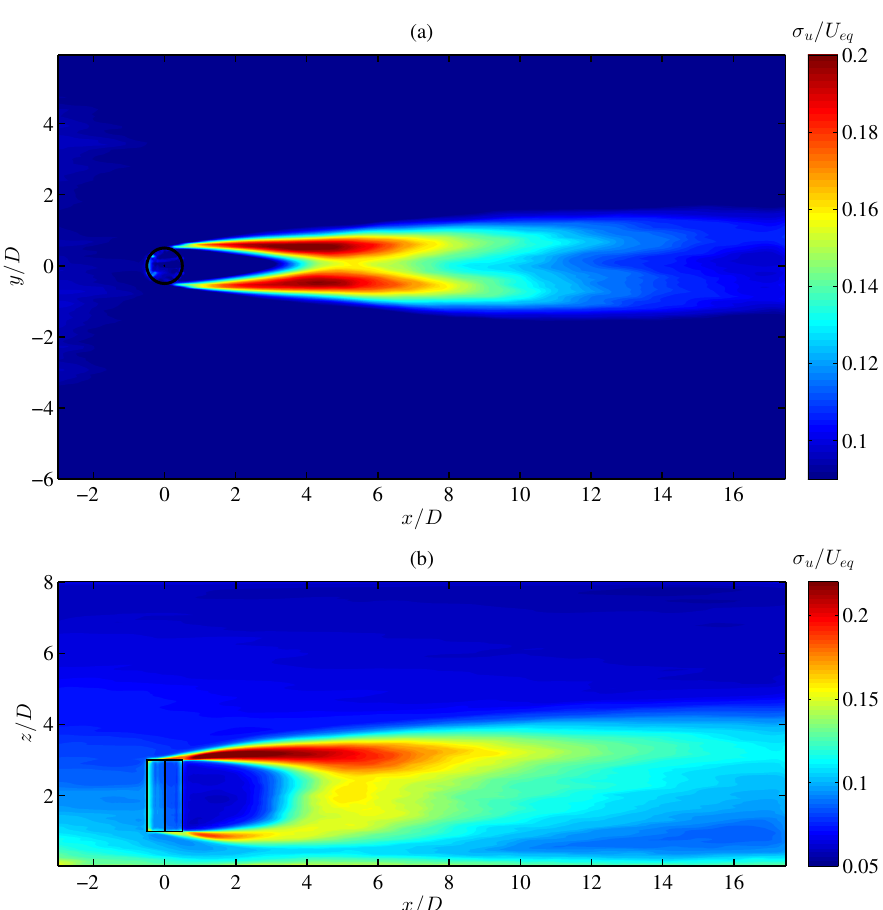
Figure 11. Contour plots of the streamwise turbulence intensity, σ u / U eq : ( a ) in the x - y plane at the equator height of the turbine; ( b ) in the x - z plane going through the center of the turbine. 1 D